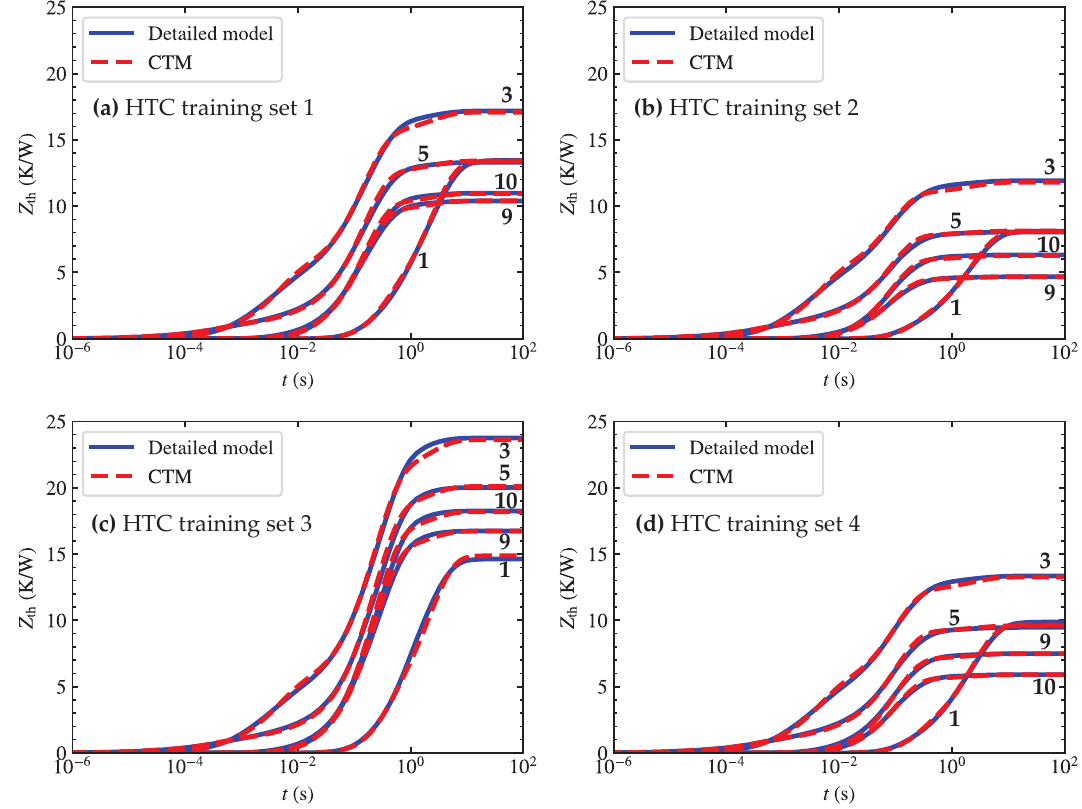
Figure 7. Transient behavior of the LED detailed model (blue) and optimized LED CTM (red) for ( a ) HTC training set 1, ( b ) HTC training set 2, ( c ) HTC training set 3, and ( d ) HTC training set 4. The numbers correspond to the nodes of the RC-network: 1-dome, 3-phosphor, 5-junction, 9-thermal pad, and 10-dome.